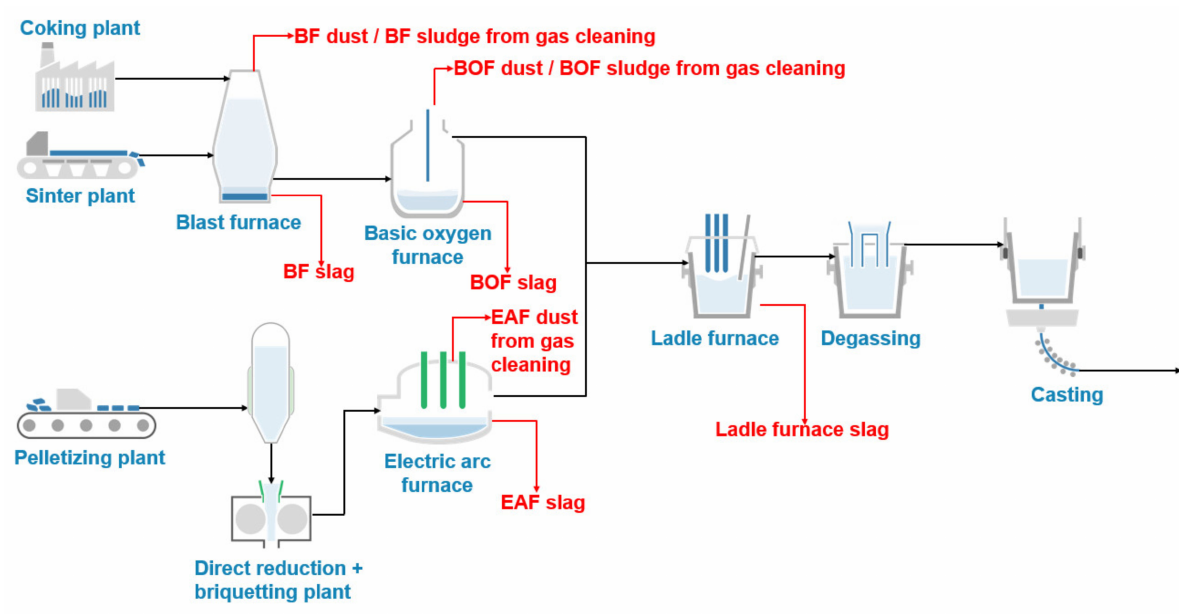
Figure 3. BF-BOF and EAF routes (with a direct reduction process for iron ore reduction) for primary steel production and the place of generation for the main steelmaking residues.